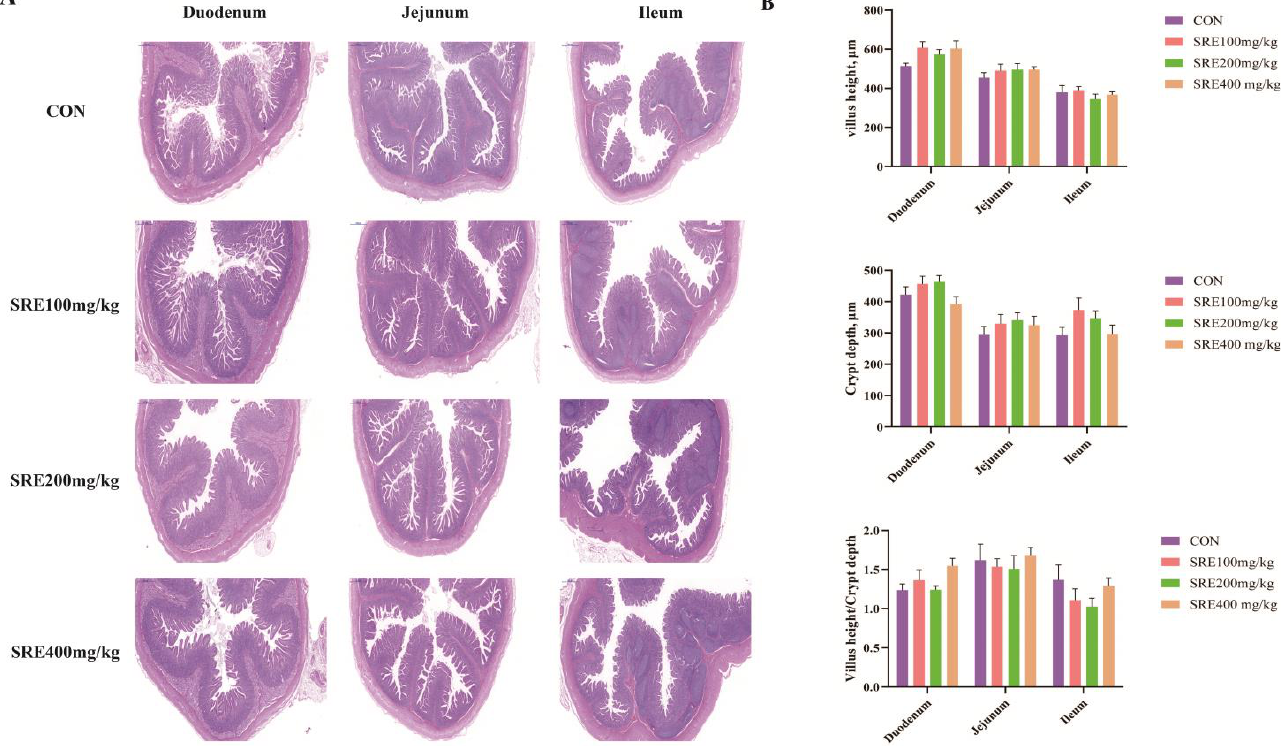
Figure 1. Effects of supplementation of stevia residue extract in the diet on small intestine morphology of weaned piglets on day 42 of the trial. Hematoxylin–eosin staining photos of the duodenum, jejunum, and ileum (magnification 20×) ( A ); the morphology of villus height, crypt depth, and villus height/crypt depth ( B ). Con: control group without the supplementation of stevia residue extract in the diet; SRE100 mg/kg: diets supplemented with 100 mg/kg stevia residue extract group; SRE200 mg/kg: diets supplemented with 200 mg/kg stevia residue extract group; SRE400 mg/kg: diets supplemented with 400 mg/kg stevia residue extract group. Values are means ± SEM, n = 6. Labeled means in a row with different letters differ, p < 0.05.